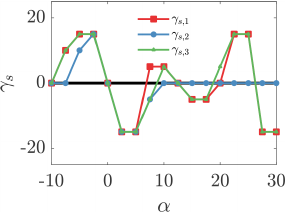
Figure E1. Yaw misalignment set-point lookup table for open-loop control for turbines 1, 2, and 3 as a function of the incident wind